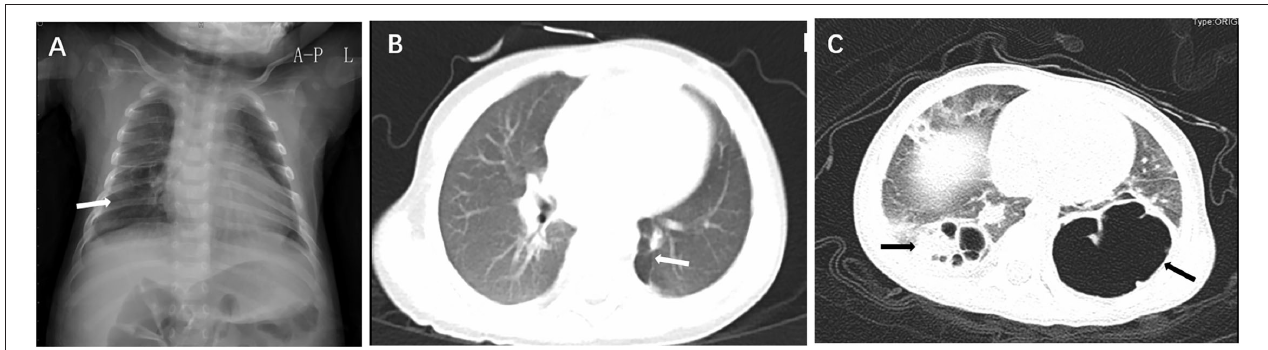
FIGURE 1 | Chest X-ray showed translucency of the right lower lobe ( A , arrow); CT scan of the chest showed a single cyst at the left lower lobe ( B , arrow) and bilateral cysts in left and right lower lobes ( C , arrows).